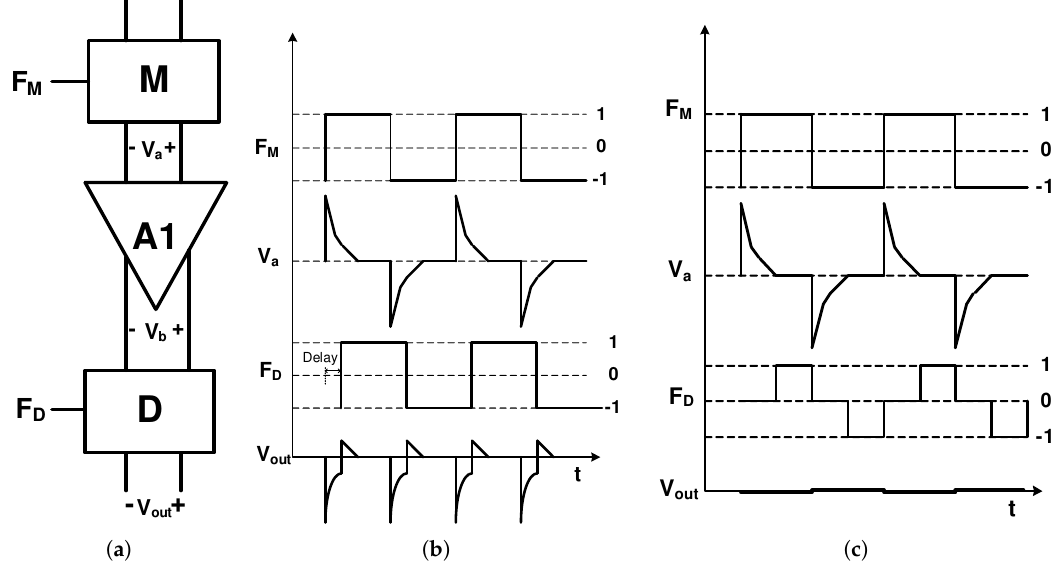
Figure 9. ( a ) Delayed modulation technique; ( b ) delayed demodulation clock diagram; and ( c ) dead-band clock diagram.